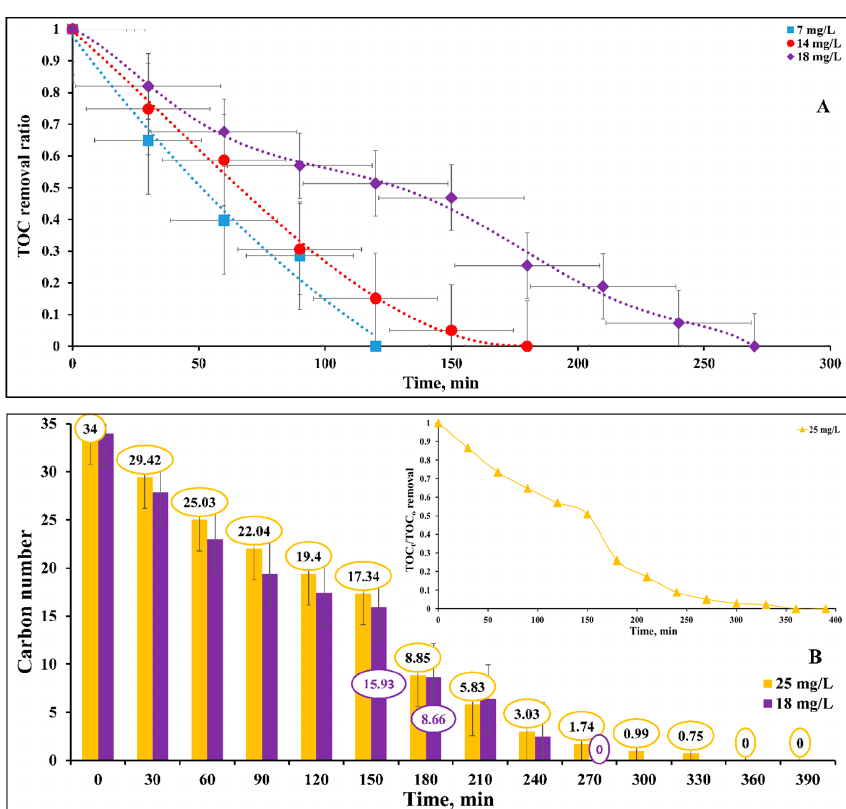
Figure 11. ( A ) Influence of initial dye concentrations on the mineralization of DB15 at natural pH, catalyst loading 0.5 g/L, and light intensity 11.2 W/m 2 . ( B ) Behavior of carbon degradation through DB15 mineralization at different initial concentrations (natural pH, catalyst loading 0.5 g/L, and light intensity 11.2 W/m 2 ).